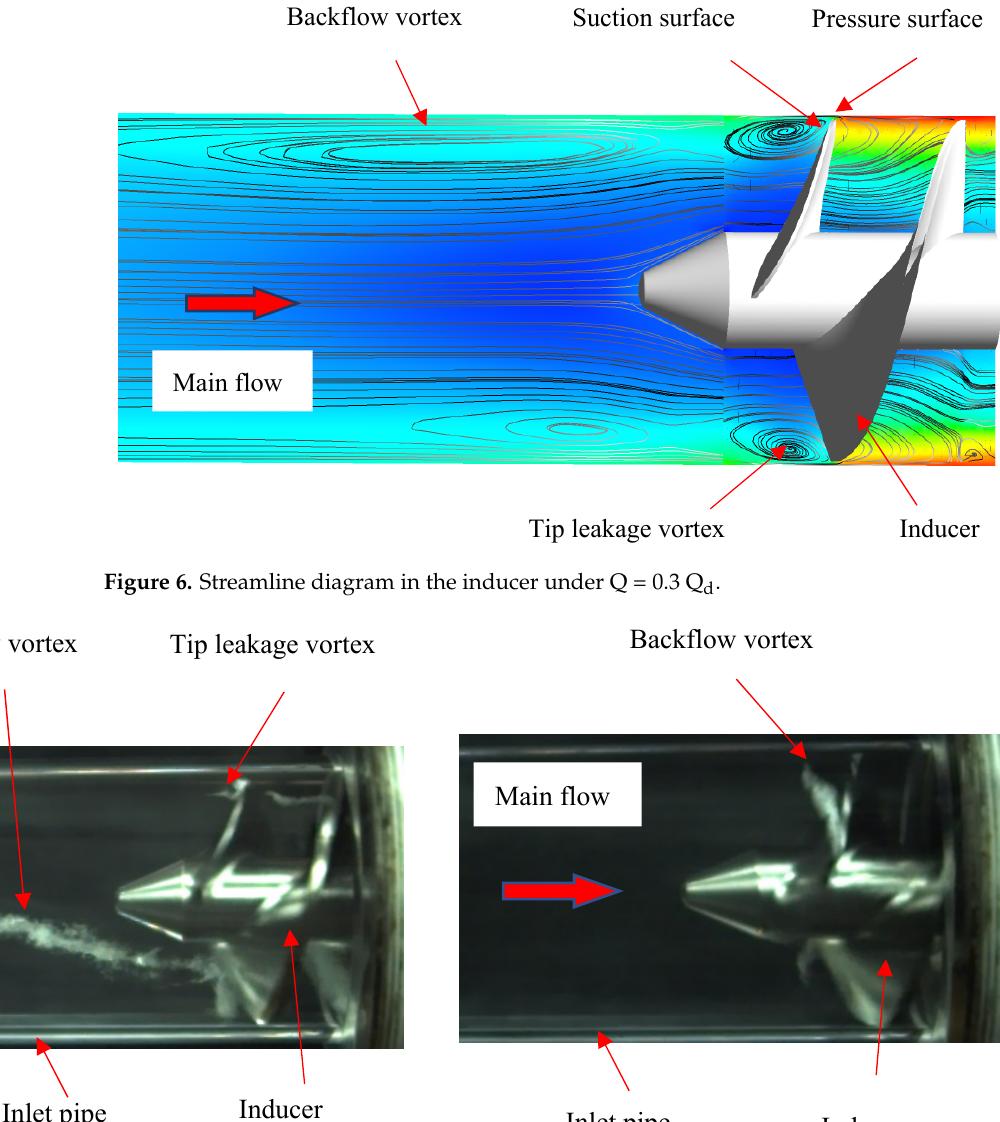
Figure 6. Streamline diagram in the inducer under Q = 0.3 Q d .